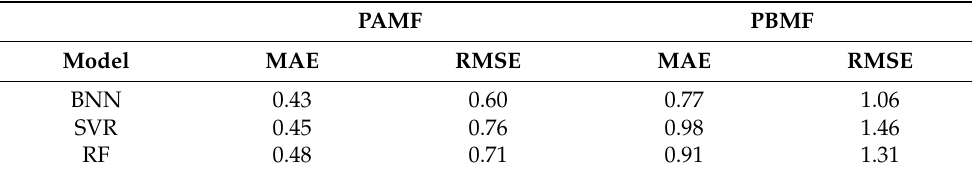
Table 2. Statistical indexes for the outcomes of the training step from different models.